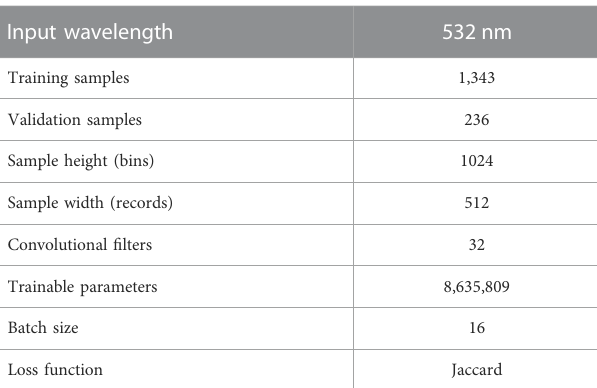
TABLE 1 Parameters used for the